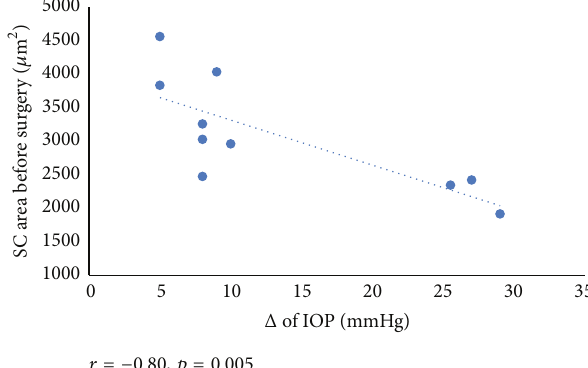
Figure 3: Scattergram showing the relationship between the SC area before surgery and the reduction of